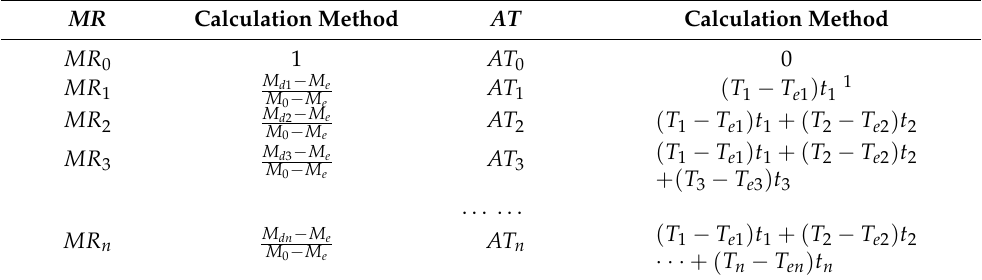
Table 1. Calculation method of moisture ratio and drying accumulated temperature.